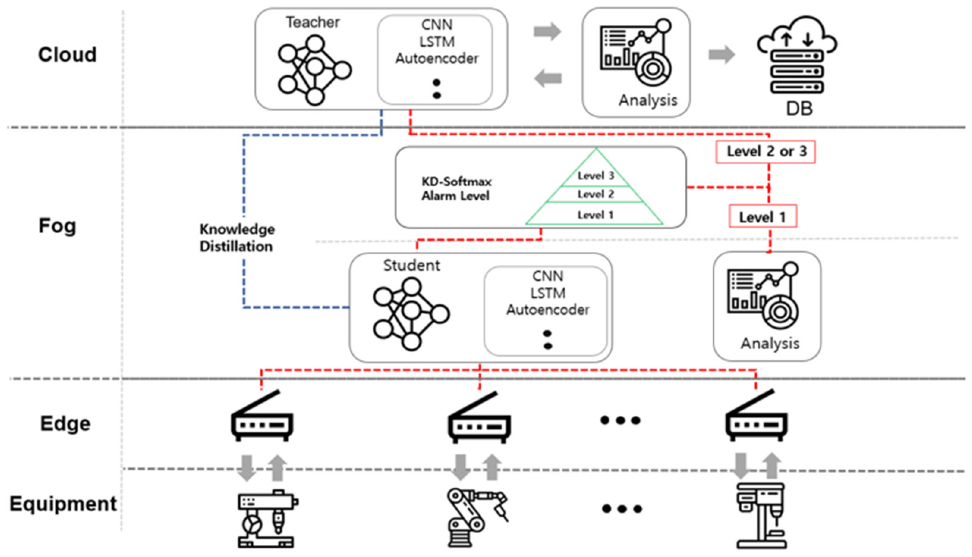
Figure 2. The architecture of the cloud–fog–edge alarm-level-based heterogeneous device knowledge distillation for the IIoT.